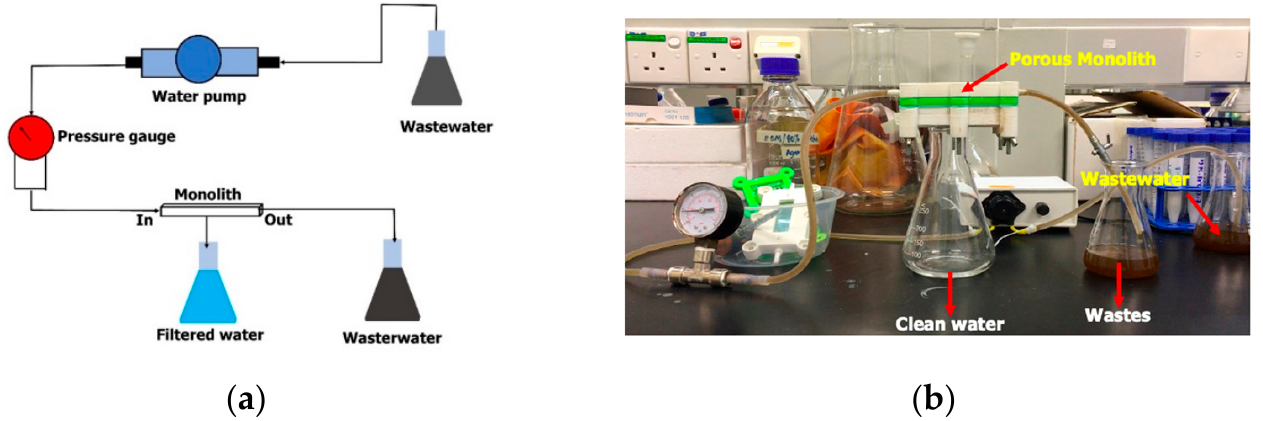
Figure 2. ( a ) Schematic representation of the monolith water filtration system. ( b ) Actual monolith water filtration system using the developed microsphere-templated porous monoliths.